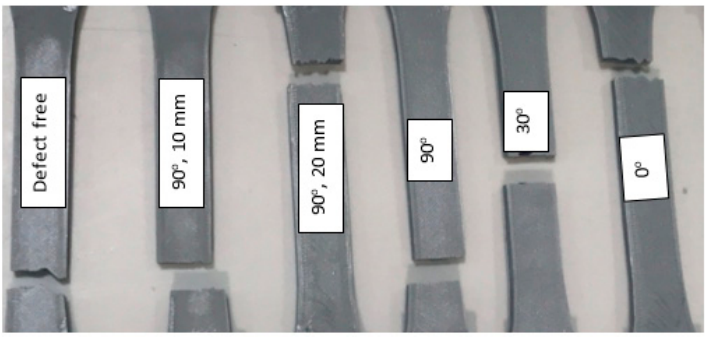
Figure 12. Fractured gray samples.